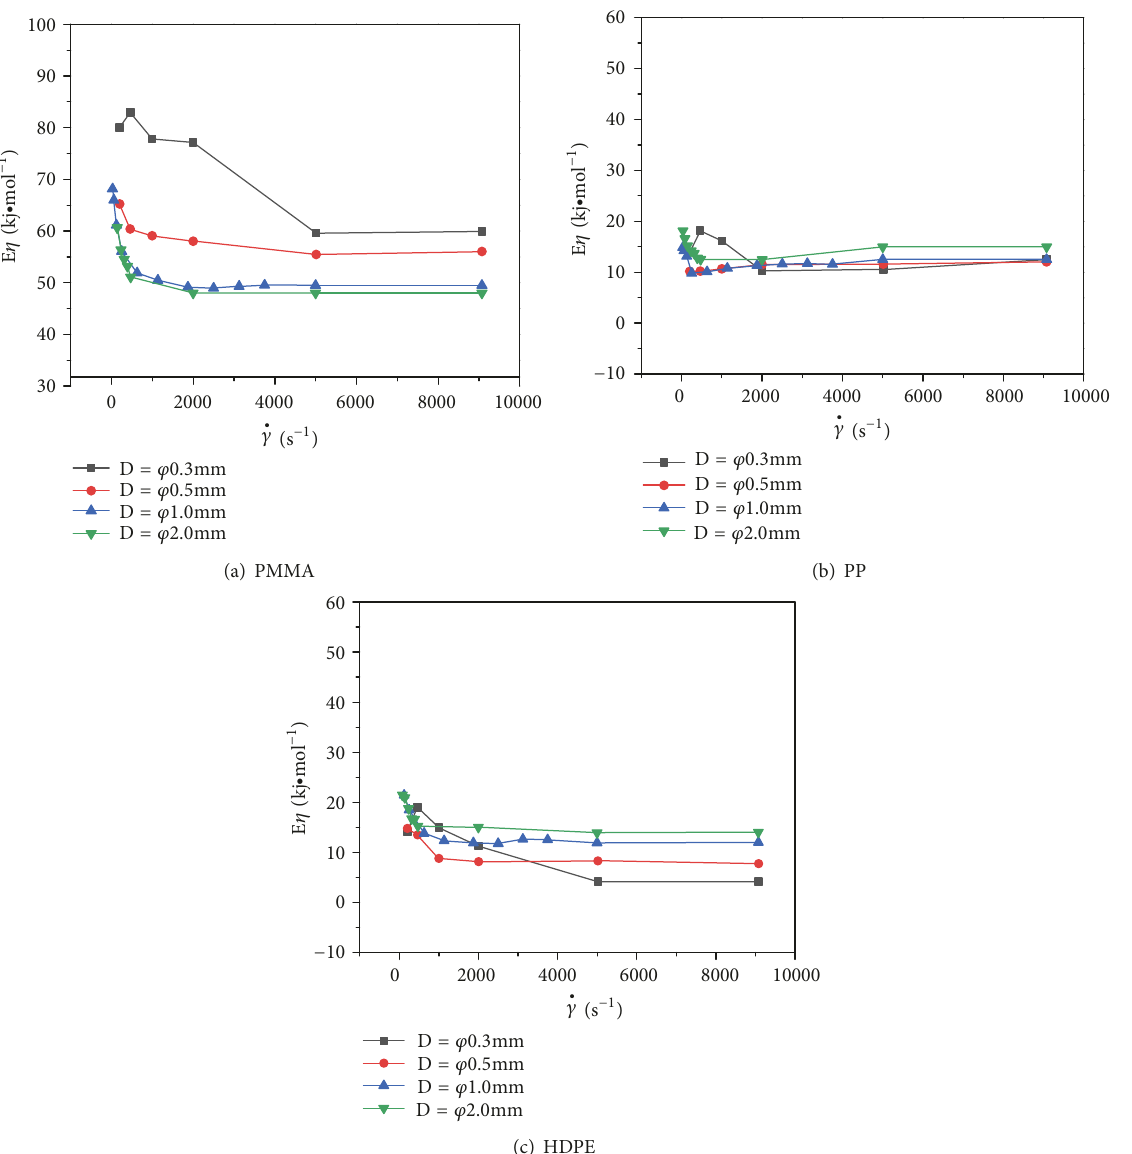
Figure 1: Curve of viscous flow activation energy to shear rate for three materials at different hole diameters of the die. (a) PMMA; (b) PP; (c)